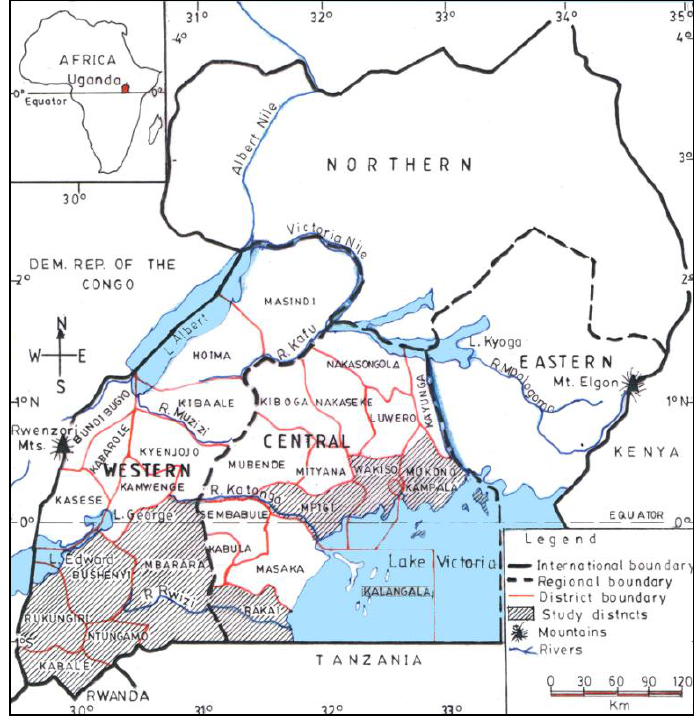
Fig. 1. Location of the districts of Uganda where the study was carried out, 2015